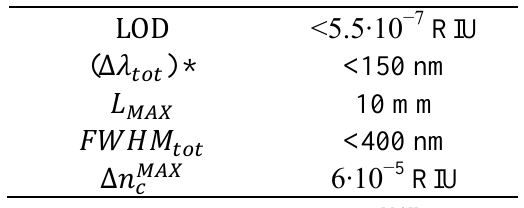
Table 1. Design Specification for CO